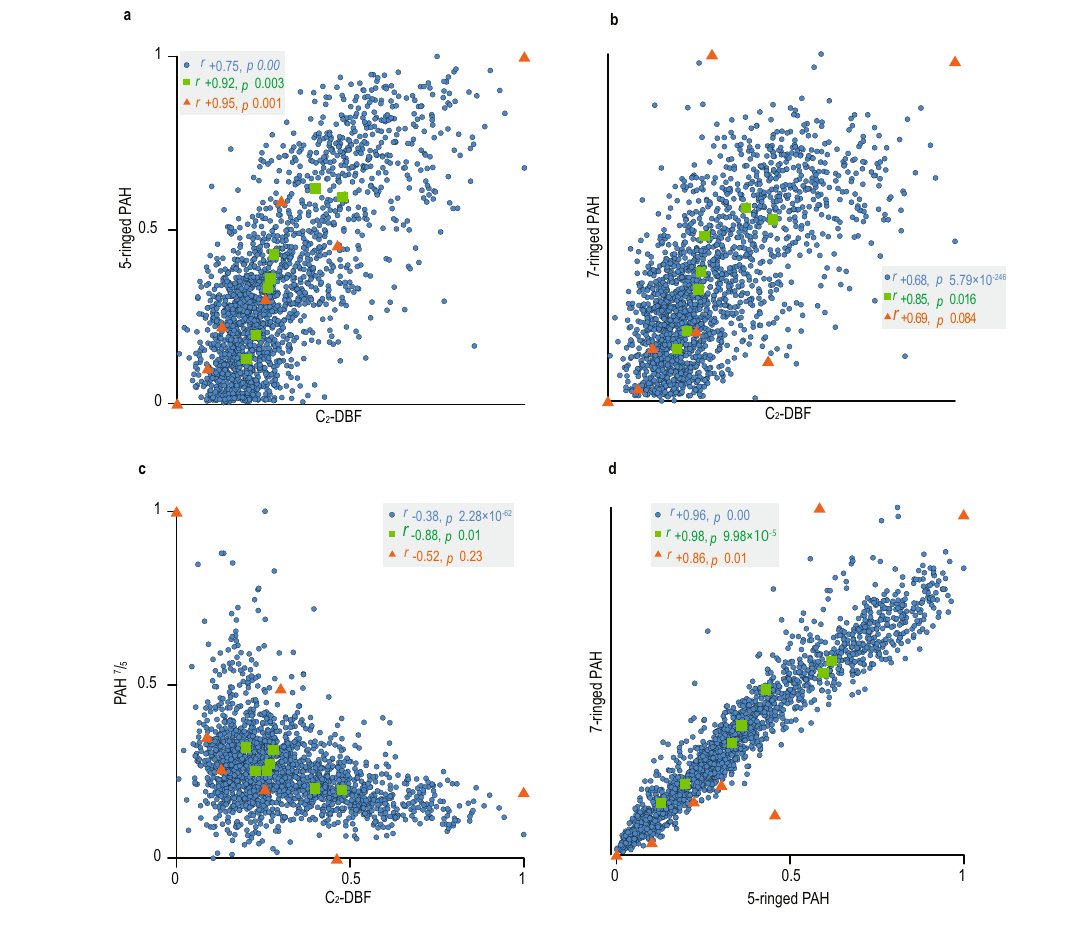
Fig. 3 | Pyrogenic PAHs vs. soil organic matter. Cross-plots of molecular bio- markers for pairs of fi ve-ringed PAH and C 2 -DBF ( a ), seven-ringed PAH and C 2 -DBF ( b ),PAH 7 / 5 andC 2 -DBF( c ),andseven-and fi ve-ringedPAHs( d ).Theseven-and fi ve- ringed PAHs and PAH 7 / 5 are shown as markers for combustion and combustion temperature,respectively(seetext),andC 2 -DBFasmarkersforsoilorganicmatter. Bluecircles:MSIdata;orangetriangles:GC-MSdata;greensquares:themeanvalues of MSI data corresponding to the stratigraphic range for each sample of GC-MS